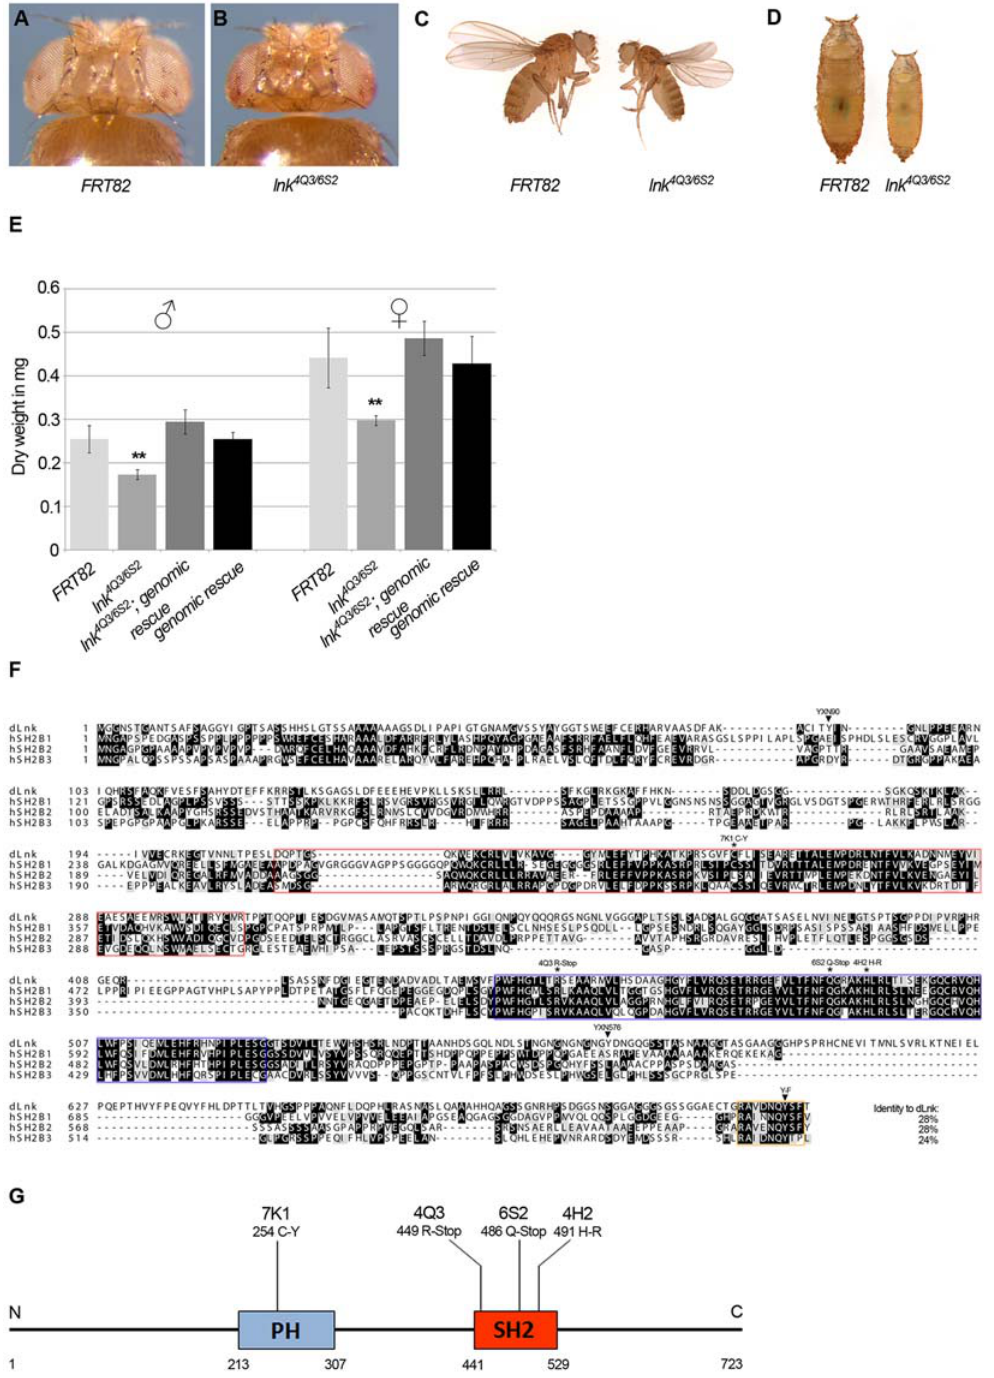
Figure 1. Flies mutant for lnk are viable but small. (A–D) lnk regulates organismal size throughout development. In comparison to ey-flp induced control clones ( FRT82 , A), FRT82 lnk 4Q3 clones result in a small head phenotype (B). lnk 4Q3 / lnk 4Q3 adult flies (C) and pupae (D) are smaller than the controls. (E) Flies lacking lnk function are strongly reduced in dry weight. Introduction of a genomic construct comprising the lnk locus rescues the lnk growth deficit. Significant changes relative to the control ( p # 0.01, Student’s t-test, n=20) are marked by double asterisks; error bars represent the standard deviation. (F) Alignment of the Drosophila Lnk protein and its human homologs of the SH2B family of adaptor proteins. lnk codes for a 723 amino acid adaptor protein containing a PH domain and an SH2 domain. Black and grey boxes indicate amino acid identity and similarity, respectively. The SH2 domain is highlighted in red, the PH domain in blue, and the highly conserved Cbl binding motif in orange. Asterisks mark the mutations recovered in the screen, and arrowheads indicate the tyrosines of the two potential YXN Drk SH2 binding motifs and the conserved Cbl binding motif. (G) The mutations leading to an amino acid exchange in the PH domain (7K1) and to premature translational stops (4Q3, 6S2) or an amino acid exchange in the SH2 domain (4H2), respectively, genetically behave as null alleles, indicating that both the PH and the SH2 domain are essential for Lnk’s function. Genotypes are: (A) y w ey-flp / y w ; FRT82 / FRT82 cl(3R3) w + , (B) y w ey-flp / y w ; FRT82 lnk 4Q3 / FRT82 cl(3R3) w + .